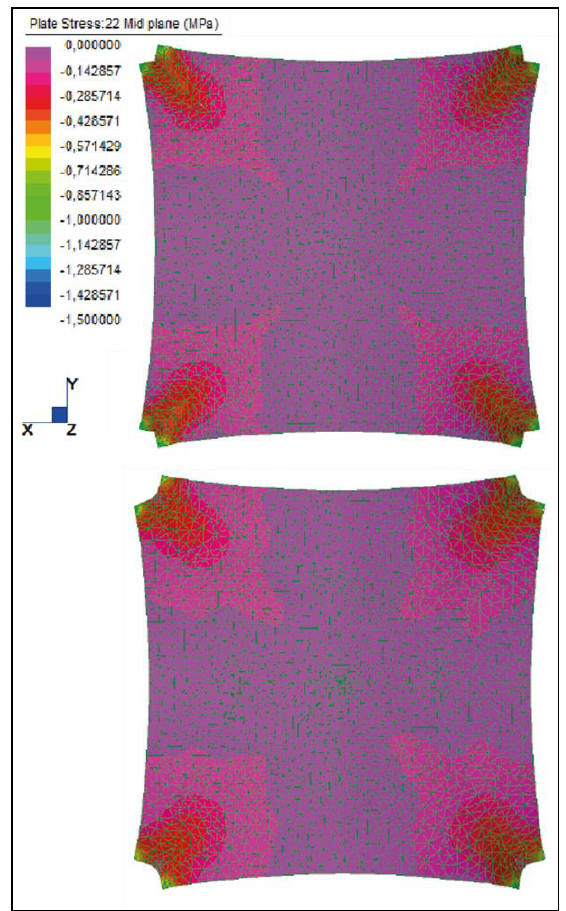
Figure 16. 2 nd principal stress in the two different 3D mesh models: on the left applied to the surface deriving from algorithmic modelling and on the right to the surface commonly derived from the point